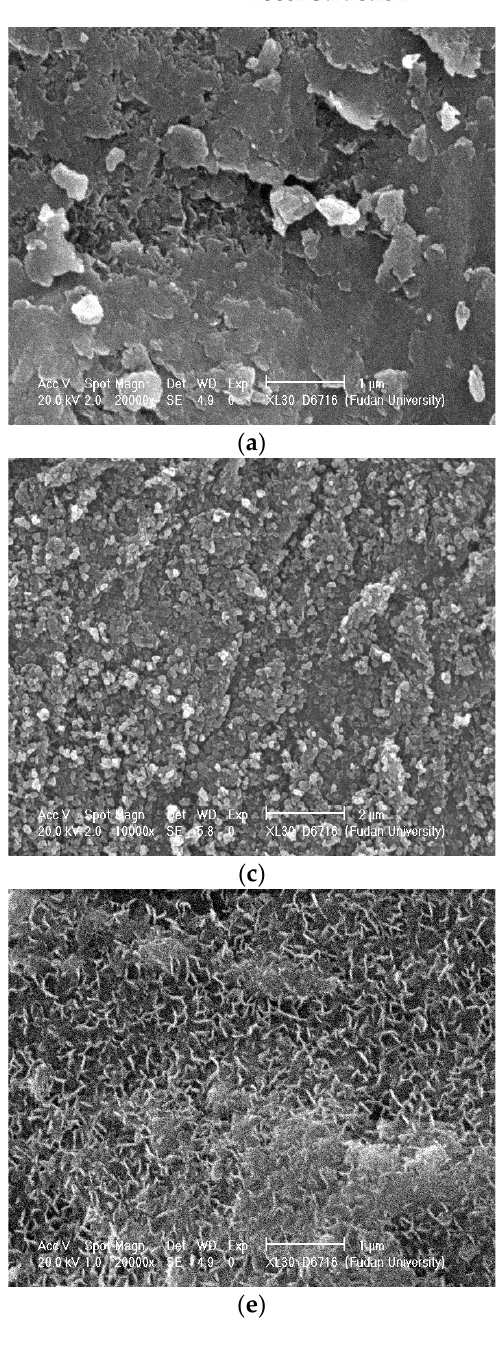
Figure 12. The SEM images of Mg-Fe-Ti-LDHs before ( a ) Mg-Fe-Ti-LDHs-Cl − -2, ( b ) Mg-Fe-Ti-LDHs- CO 32− , ( c ) Mg-Fe-Ti-CLDH) and after ( d ) Mg-Fe-Ti-LDHs-Cl − -2, ( e ) Mg-Fe-Ti-CLDH) vanadate adsorption.